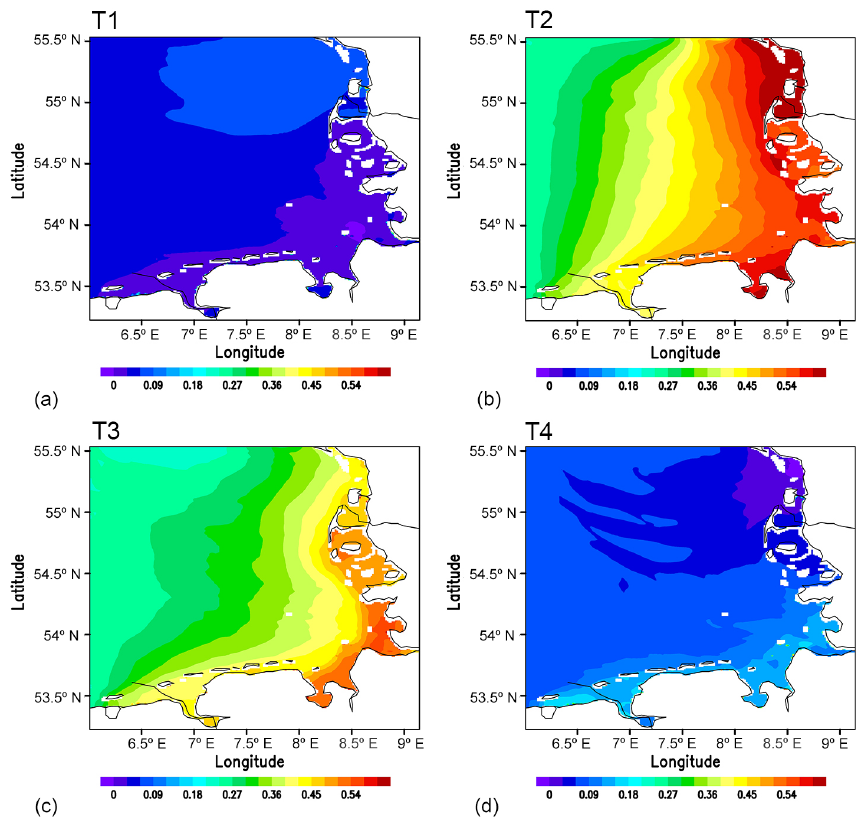
Figure 12. Maximum surge differences between FULL and CTRL runs in (m) for T1–T4 tidal periods as shown in Fig.